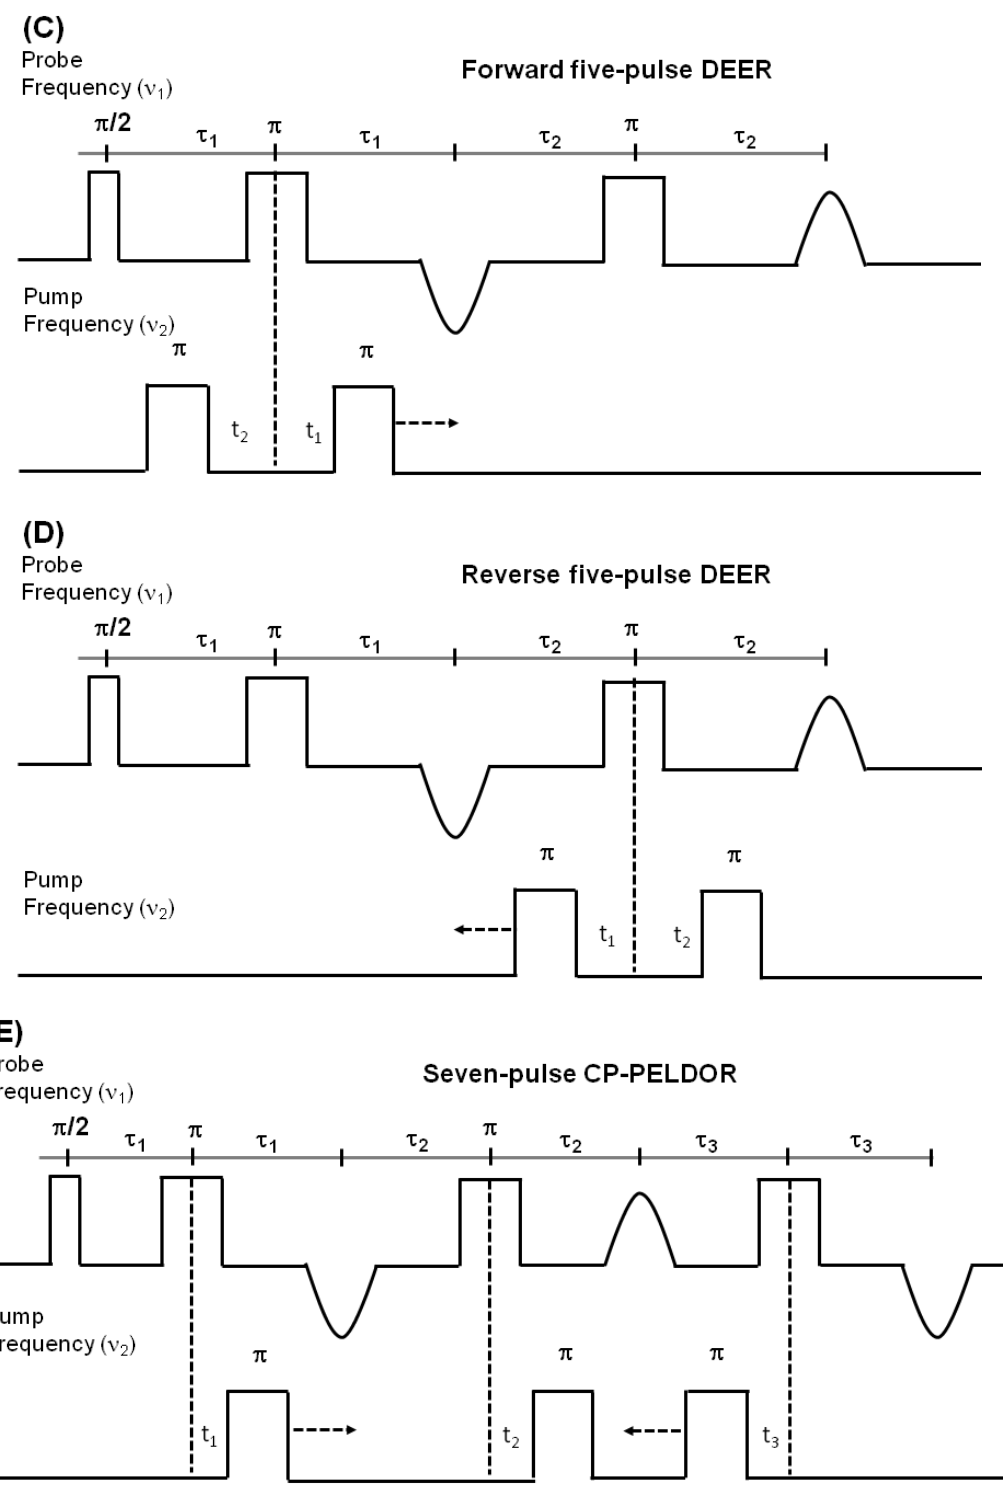
Figure 8. Double electron electron resonance DEER spectroscopic method used to measure distances between nitroxide spin labels. ( A ) Distance vector (d) between spin S 1 and S 2 on KCNE1 membrane protein (PDB ID: 2k21) at an angle θ with the magnetic field B 0 . ( B ) Four-pulse DEER sequence. ( C ) Forward five-pulse DEER sequence. ( D ) Reverse five-pulse DEER sequence. ( E ) Seven-pulse CP-PELDOR sequence [143,144].